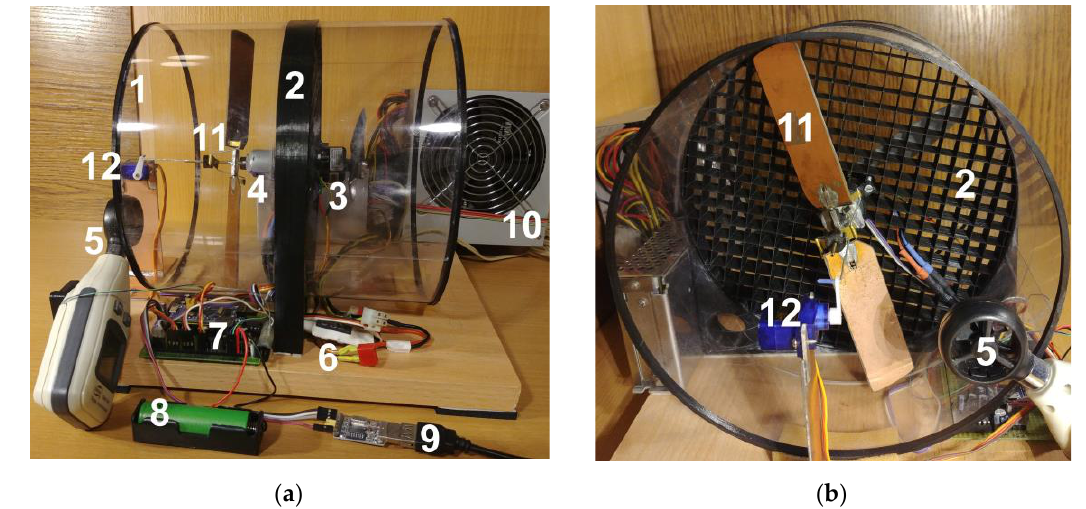
Figure 9. ( a ) View of the research model; ( b ) View of the wind tunnel.